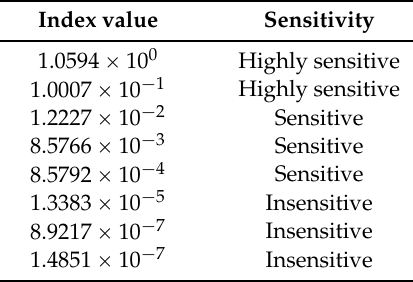
Table 4. Fractional-order model parameters sensitivity results. Table 4. Fractional ‐ order model parameters sensitivity results.